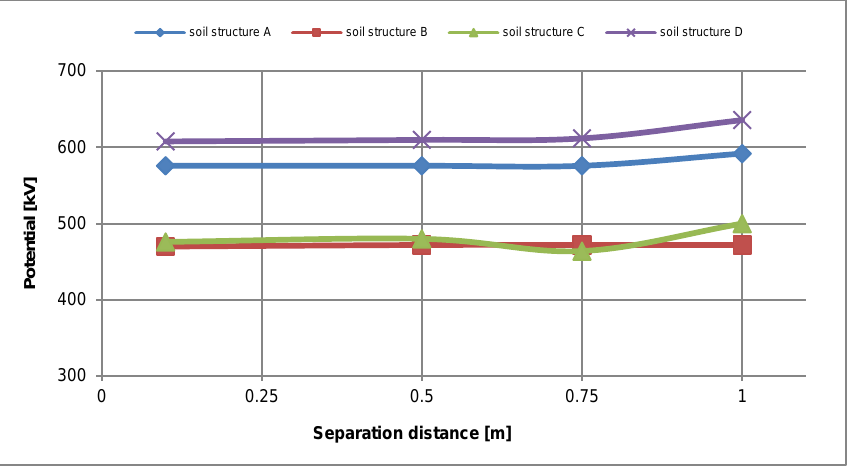
Figure 6. Maximum values of the soil surface potential calculated at a 1.5 m distance from PV panels, for alternative separation distances and soil structures.